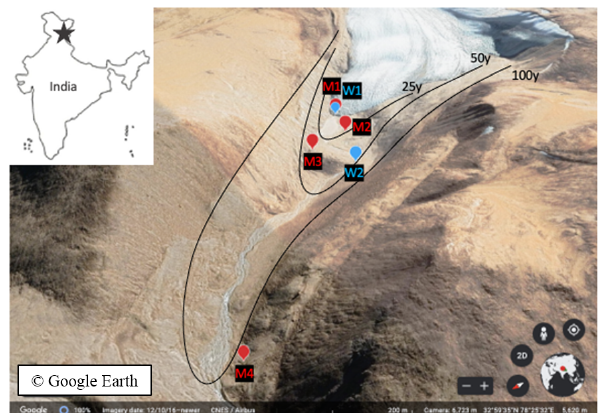
Figure 1. Chamser Kangri glacier forefield chronosequence in In- dia (adapted outline map from coloringhome.com) with sampling sites (M for soils and W for stream water and glacier snout) in- dicated on a satellite map (35 ◦ 57 (cid:48) 55 (cid:48)(cid:48) N, 78 ◦ 24 (cid:48) 25 (cid:48)(cid:48) E. © Google Earth, CNES/Airbus, 12 April